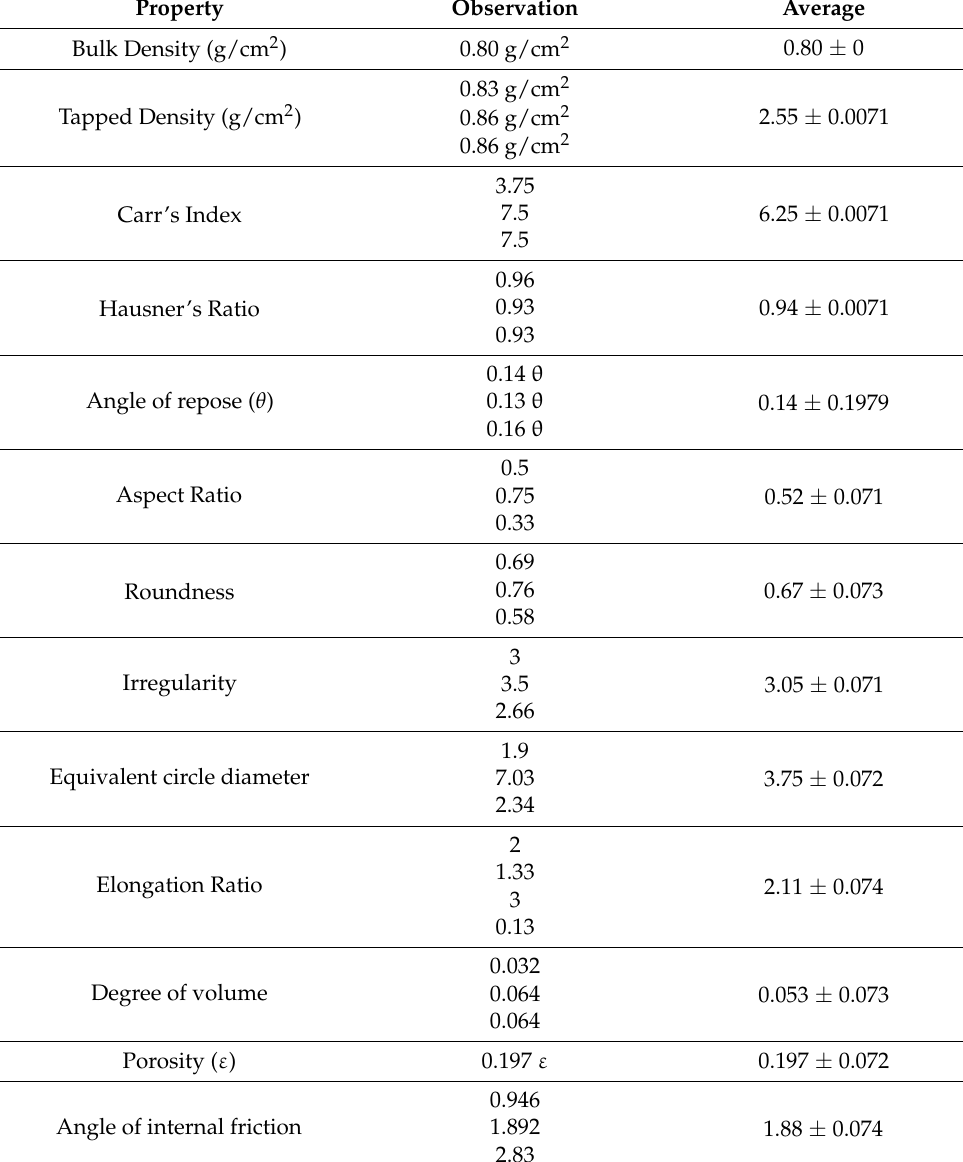
Table 2. Micromeritics properties of